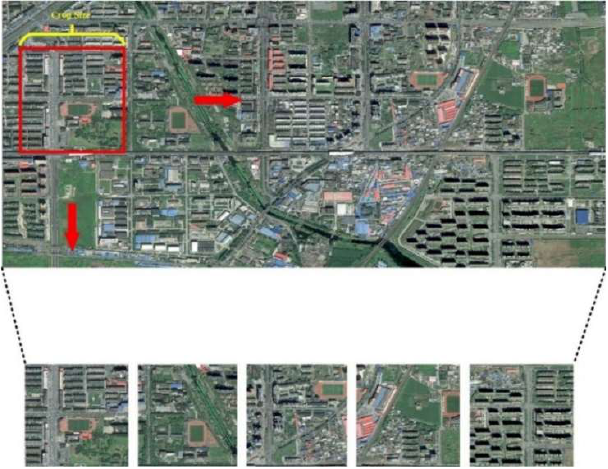
Figure 3. The process of cropping GF-2 images, the crop size is 768 × 768.